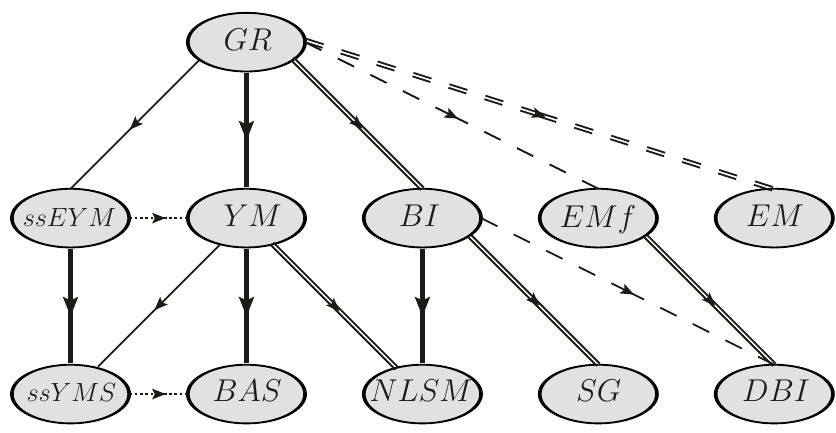
Figure 3 . Unified web for 1 -loop Feynman integrands. The bold straight line represents the operator T [ σσσ ] , the straight line represents the operator T ◦ n the operator L D , the dashed line represents the operator T represents the operator T ( D + 1) , the thin dashed line represents the insertion X 2 m